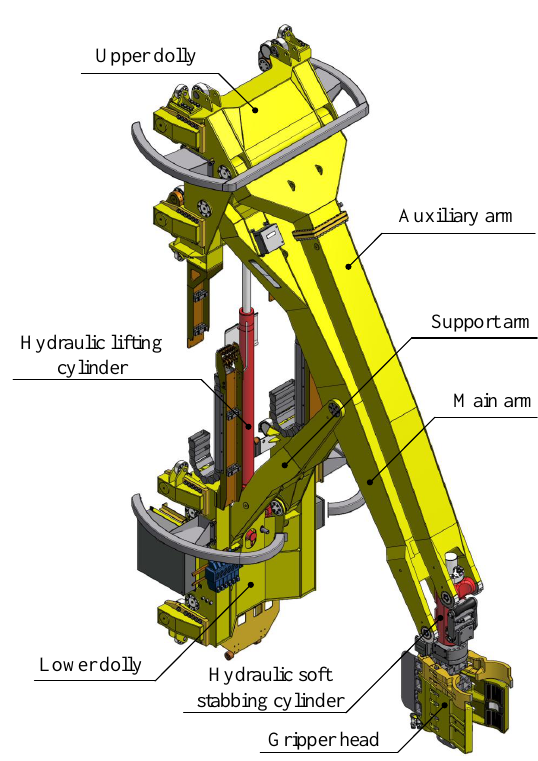
Figure 4: SmartRacker R (cid:13) gripper arm - courtesy of Cameron Sense AS.